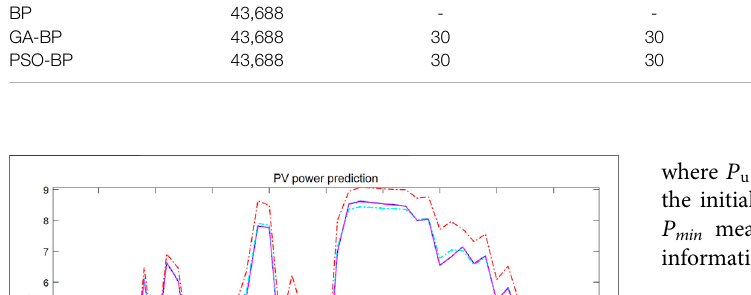
TABLE 1 | Parameter settings of each neural network algorithm. Neural network algorithm